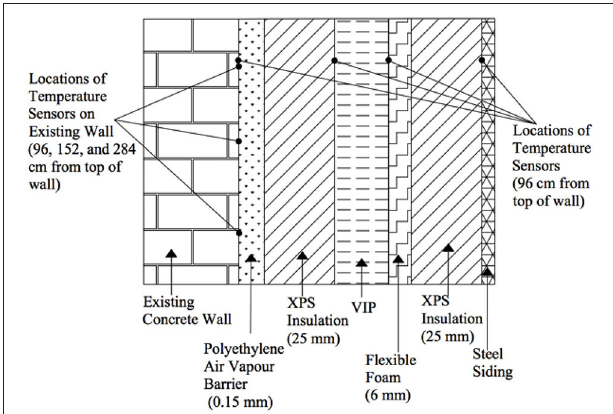
FIGURE 6 | Schematic diagram of the retrofitted wall cross-section starting from cladding onwards and the locations of the temperature sensors (thermistors) (MacLean and Korn, 2011). This drawing is not to scale. Two sets of thermistors are installed at different locations along the length of the wall (one set is near the north edge and the other is near the south edge).